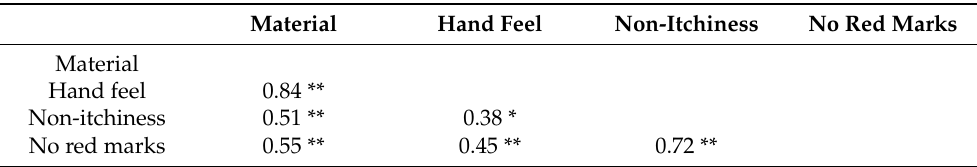
Table 3. Spearman’s correlation matrix of sensory/tactile comfort. Material Hand Feel No Red Marks